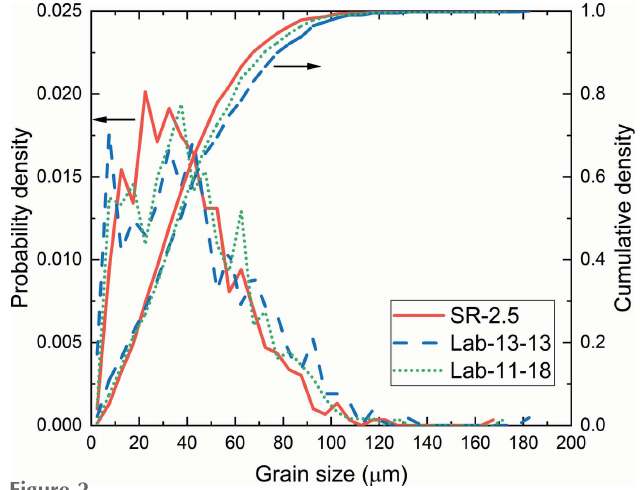
Figure 2 The grain size distribution and cumulative density for the three datasets.